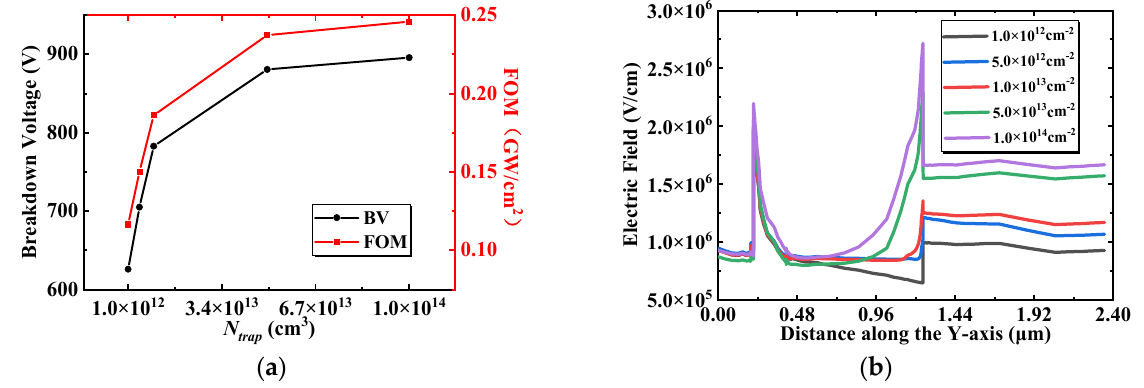
( b ) Figure 9. ( a ) Vertical electric field distribution versus distance along the Y -axis for various Si 3 N 4 buried layer thicknesses. ( b ) Impact ionization rate with a buried layer thickness of 2.175 μ m. The SiN x passivation layer on the surface of the device is widely utilized to suppress the current collapse, and the interface states between the SiN x and AlGaN barrier layers have been broadly investigated [32–35]. The existence of donor-type traps between the interface has been demonstrated, and in the proposed BP-HEMT, donor-type traps are introduced correspondingly at the interface between the AlGaN buffer and Si 3 N 4 buried layer during fabrication. To further analyze the effect of interfacial donor traps on the breakdown performance of the device, a fixed energy level interfacial donor trap is set between the SiN x and AlGaN simultaneously during the simulation. Figure 10a shows the dependence of BV and FOM on the interface trap concentration ( N trap ) of the AlGaN buffer region and Si 3 N 4 buried layer. The BV and FOM increase rapidly and then stabilize as N trap increases. To analyze the reasons, Figure 10b shows the vertical electric field at x = 6.0 μ m in the off state with a drain voltage of 600 V, and for the same reason as Figure 9a, the region below the nucleation layer is not plotted. The trap located at the interface of the AlGaN buffer and Si 3 N 4 buried layer is farther away from the channel, without affecting the concentration of 2DEG, and it is quite distinct from the passivation layer trap. There- fore, the vertical electric field peak at the channel (the first peak in Figure 10b) is not af- fected by N trap . The electric field at the interface between the AlGaN buffer and the Si 3 N 4 buried layer (the second peak in Figure 10b) and the magnitude of the electric field in the Si 3 N 4 buried layer increase significantly with increasing N trap . The reason for this variation is that the high concentration donor leaves more positive fixed charges at the interface